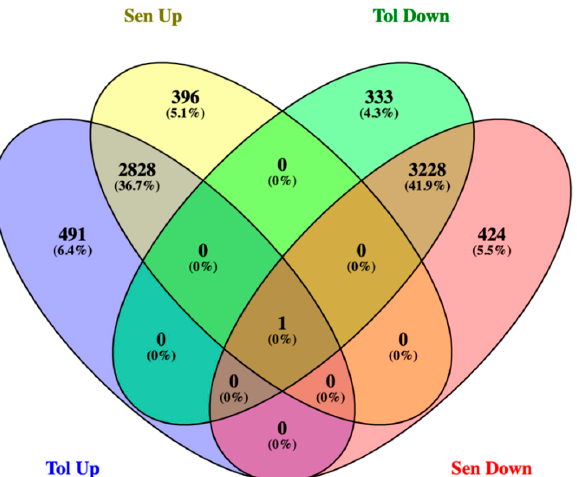
Plants 2023 , 11 , x FOR PEER REVIEW Figure 2. Venn diagram shows the potential upregulated and downregulated DEGs in tolerant and sensitive genotypes. DEGs were quantified based on log2 fold changes ±2 and FDR < 0.05.